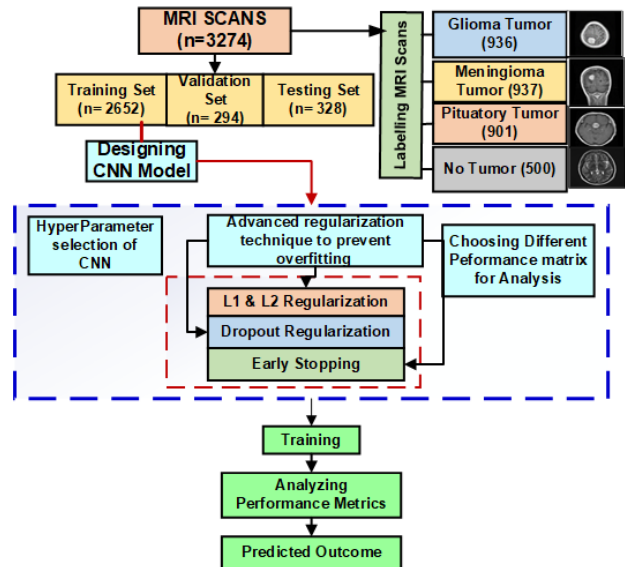
Fig. 3. Flowchart for data acquisition, CNN model designing and